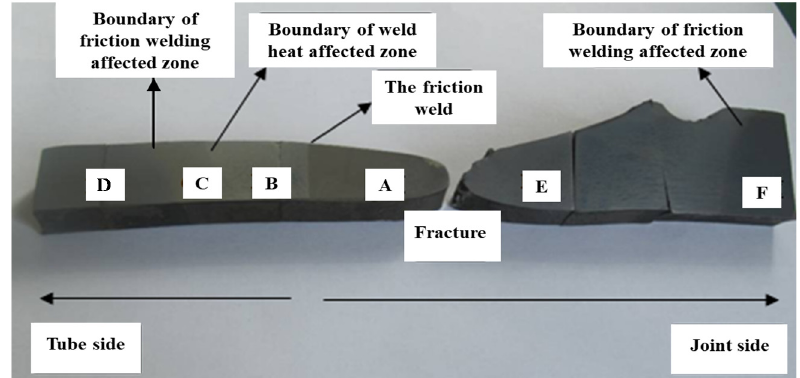
Figure 3. Sectional partition of failed sample.